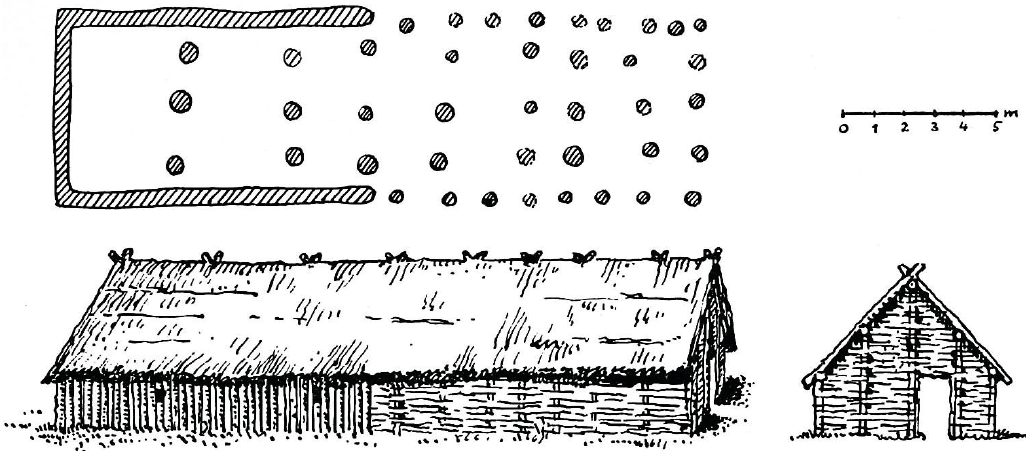
Figure 6 Ground plan and reconstruction of a typical long house at Köln-Lindenthal. Germany, c 4500–4300 BC; palisaded at the left and wattled at the right (Source: Paret 1942, 91).